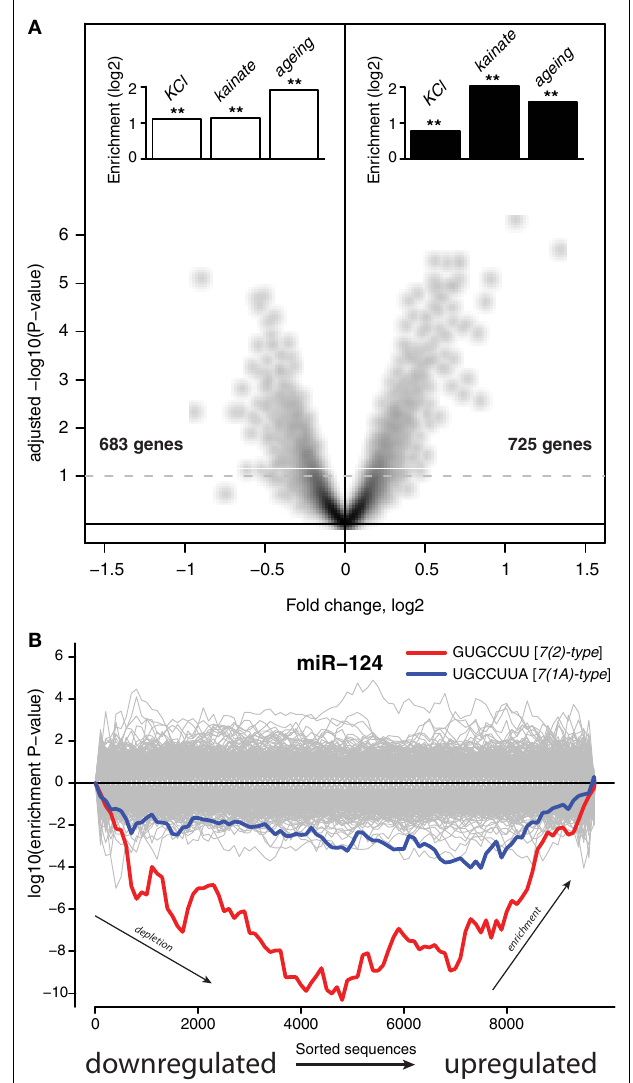
FIGURE 1 | Stress induces expression of genes subject to miRNA-mediated regulation. (A) The x -axis shows differential expression (log 2 ) between mock transfected and untransfected cultures, the y -axis shows the adjusted P -value ( − log 10 ) for differential expression. Each point on the plot uniquely represents one gene, genes above the dashed line are differentially expressed with multiple testing adjusted P < 0.1.The insets show enrichment (log 2 ) of genes either downregulated (white bars) or induced (black bars) by stressful treatments. Genes differentially expressed upon KCl treatment where identified by Illumina microarrays (Materials and Methods). Genes differentially expressed upon kainite treatment where derived from published microarray profiling data (Akahoshi et al., 2007; Materials and Methods). Mouse homologs (from HomoloGene; Sayers et al., 2010) of human genes that were previously reported as differentially expressed upon aging of the human brain comprised the aging sets. Double asterisks indicate hypergeometric P < 0.001 (Materials and Methods).The set of 10,849 genes detected by Illumina microarrays (Materials and Methods) in mock transfected and untransfected cultures was used as the universe for the hypergeometric tests. (B) The x -axis represents 3 (cid:48) UTRs corresponding to expressed genes sorted from most downregulated to most upregulated in comparison of mock